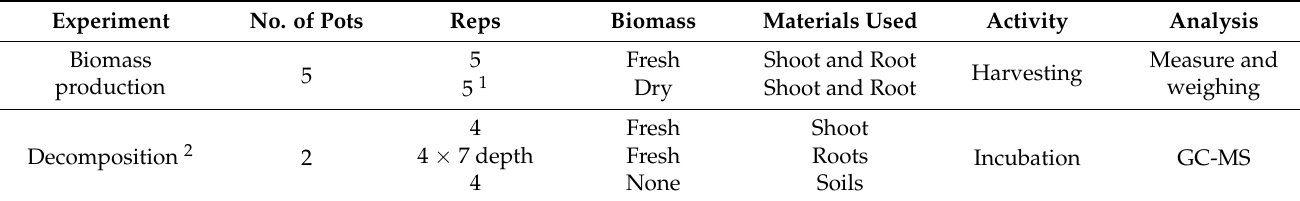
Table 6. Biomass assessment design used for biomass and decomposition